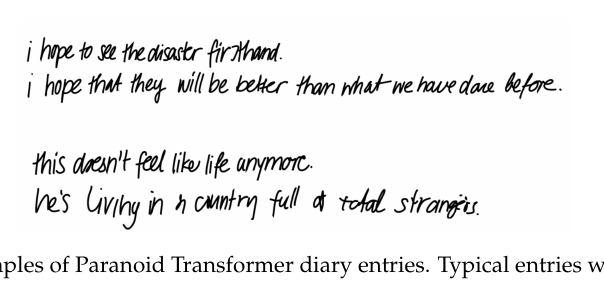
Figure 2. Some examples of Paranoid Transformer diary entries. Longer entry proxying ’self-reflection’ and personalized fringe mental state experience.